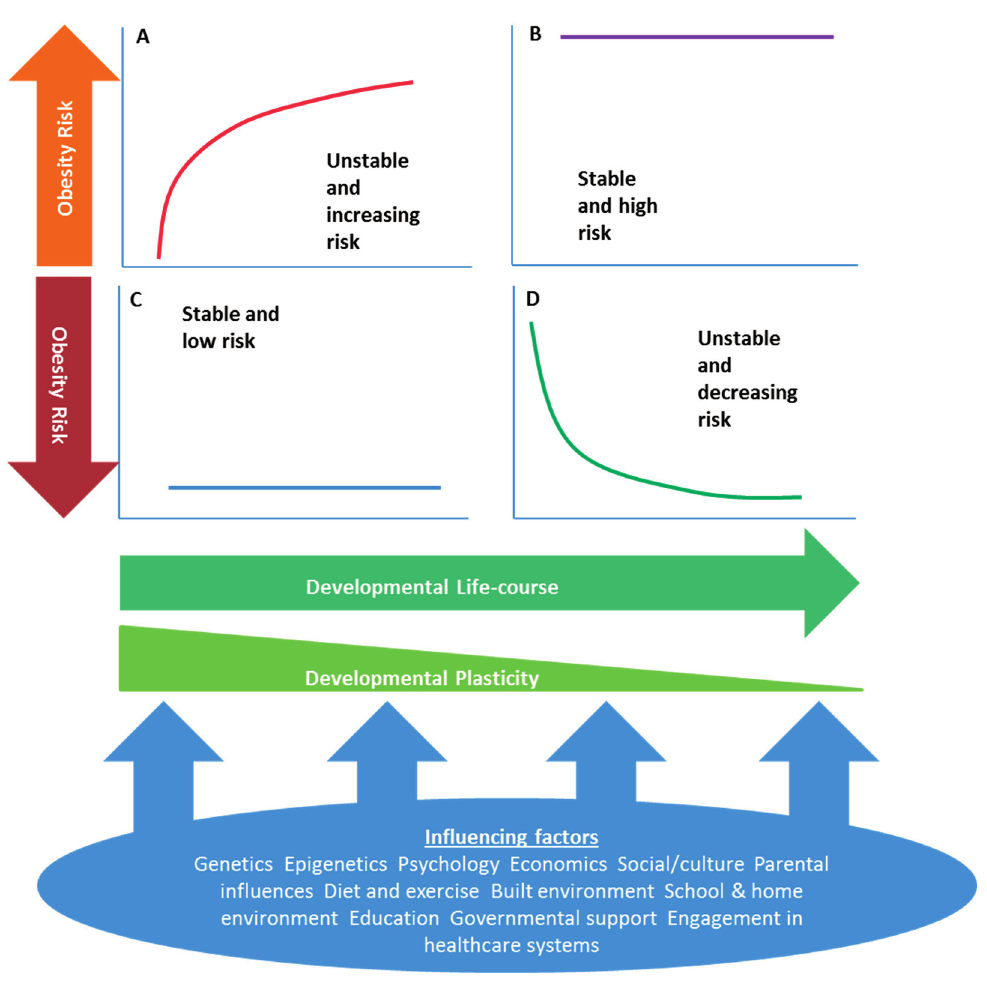
Figure 1. Obesity risk trajectories for adolescents: ( A ) Normal weight individual, BMI increasing, obesity risk increasing; ( B ) Overweight individual with stable BMI, high obesity risk; ( C ) Normal weight individual with stable BMI, low obesity risk; ( D ) Overweight individual, BMI decreasing, obesity risk decreasing. Obesity risk may be improved by lifestyle interventions that assist in switching individuals from trajectories A and B to trajectory